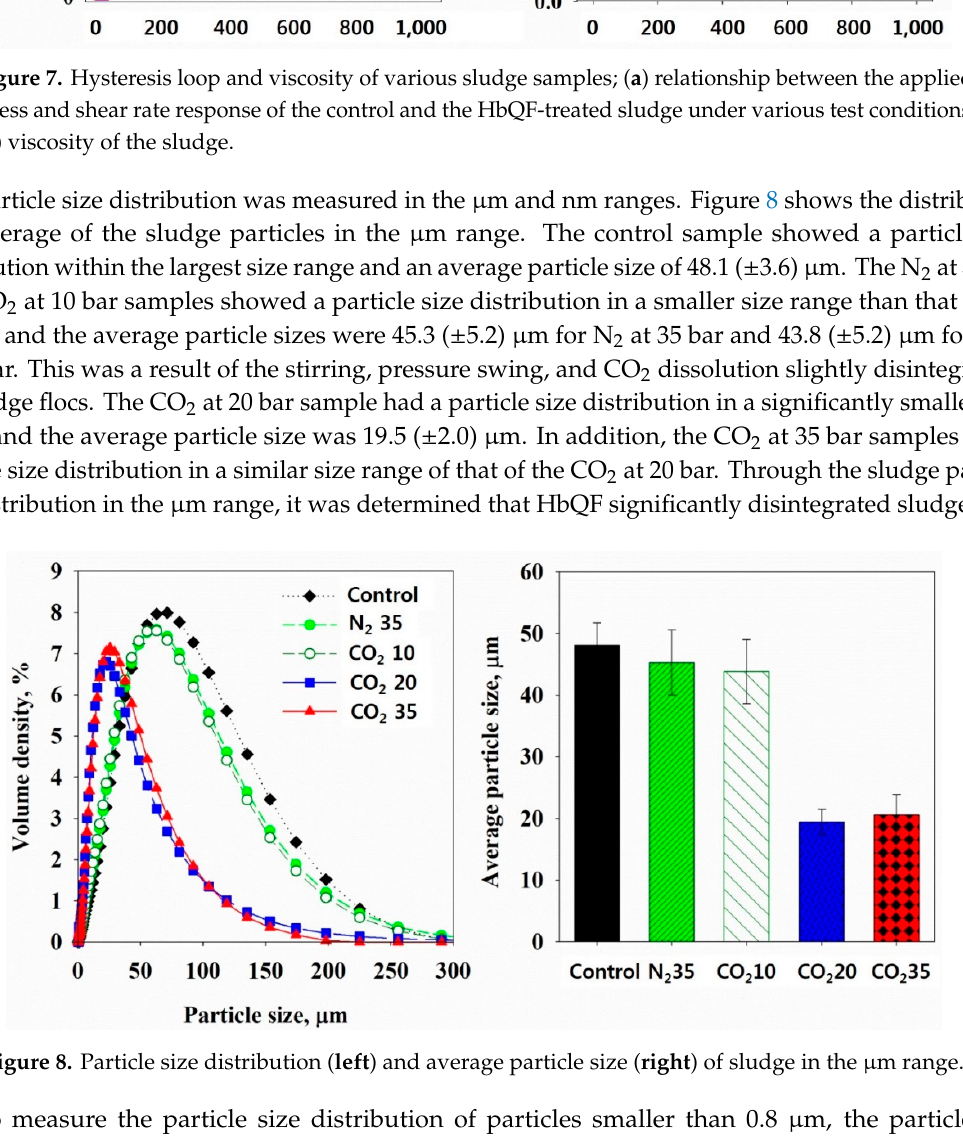
Figure 9. Particle size distribution, average particle size, and polydisperse index (PDI) in the nm range. The control had only a single peak in the less than 1000-nm range. Sludge in the N 2 at 35 bar and CO 2 at 10 bar samples showed two peaks including a small peak in the less-than-1000-nm range and a large peak in the less-than-4000-nm range. The peak in the less-than-1000-nm can be considered a result of the originally present fine particles. In addition, the other peak at less than 4000 nm can be considered a result of the fine particles produced by the slight sludge disintegration. Considering the particle size distribution in the μ m range, as the sludge was disintegrated via stirring, the pressure swing, and CO 2 dissolution, the sludge was divided into fine particles in the nm range. Via this slight disintegration, sludge of the N 2 at 35 bar and CO 2 at 10 bar samples had two peaks in the nm-range particle size distribution. Sludge of the CO 2 at 20 bar and CO 2 at 35 bar samples showed three peaks including the smallest peak at less than 1000 nm, the largest peak at less than 4000 nm, and another